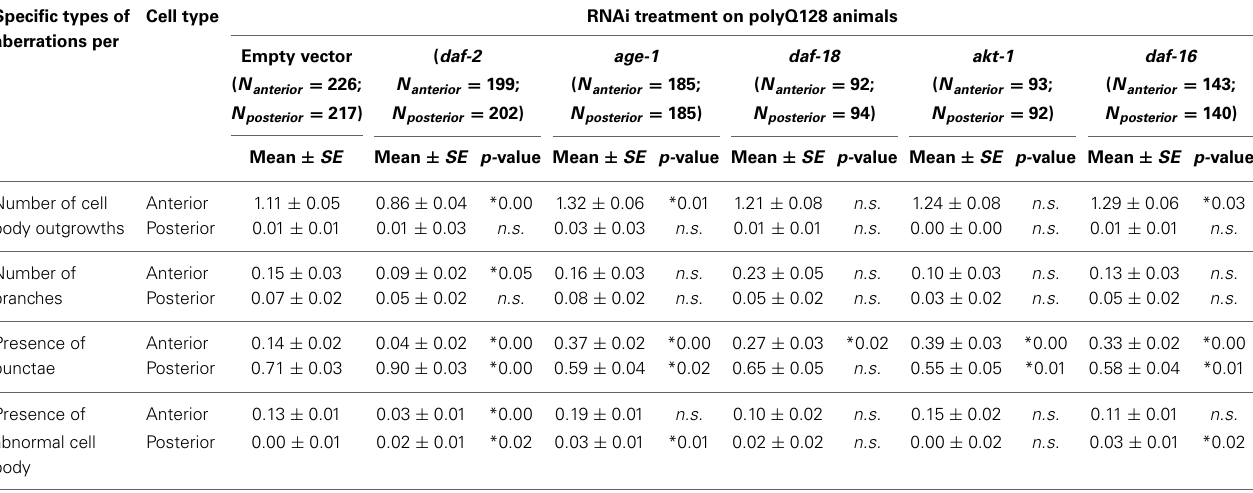
Table 3 | RNAi treatments targeting the insulin signaling pathway differentially effect polyQ128 specific mechanosensory neuronal aberrations.